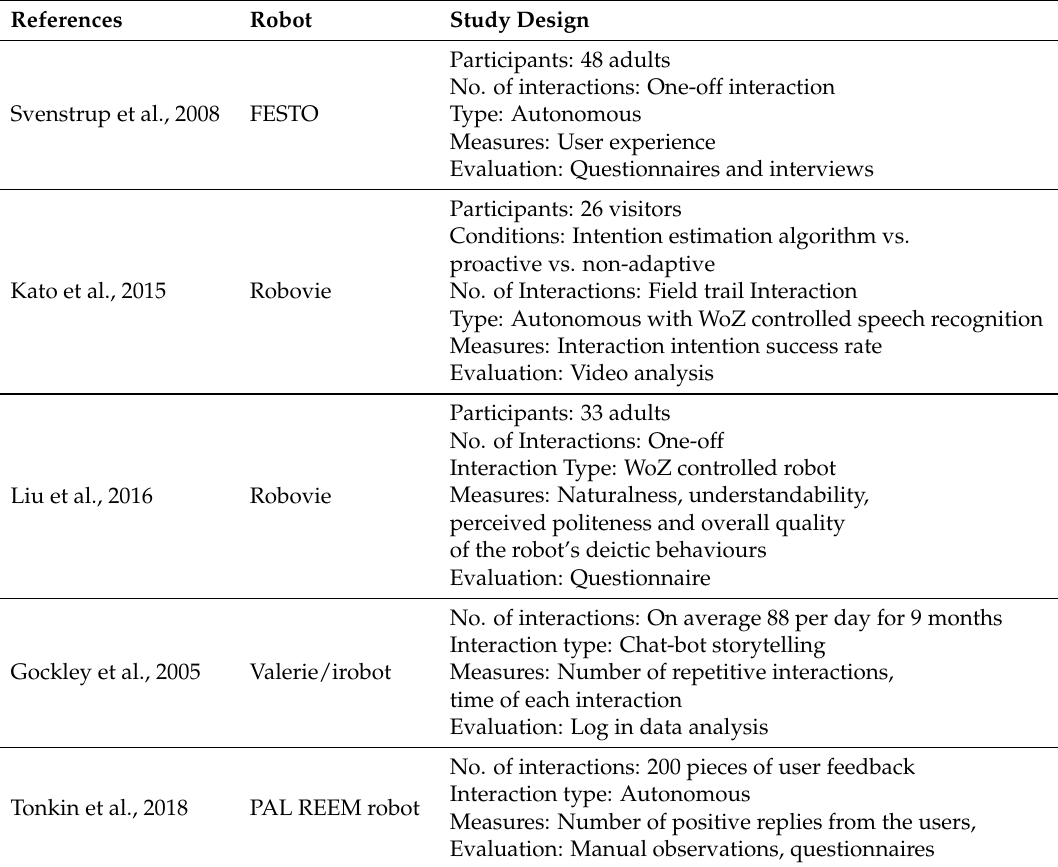
Table 1. Summary of HRI studies in the work environment and public spaces mentioned in Section